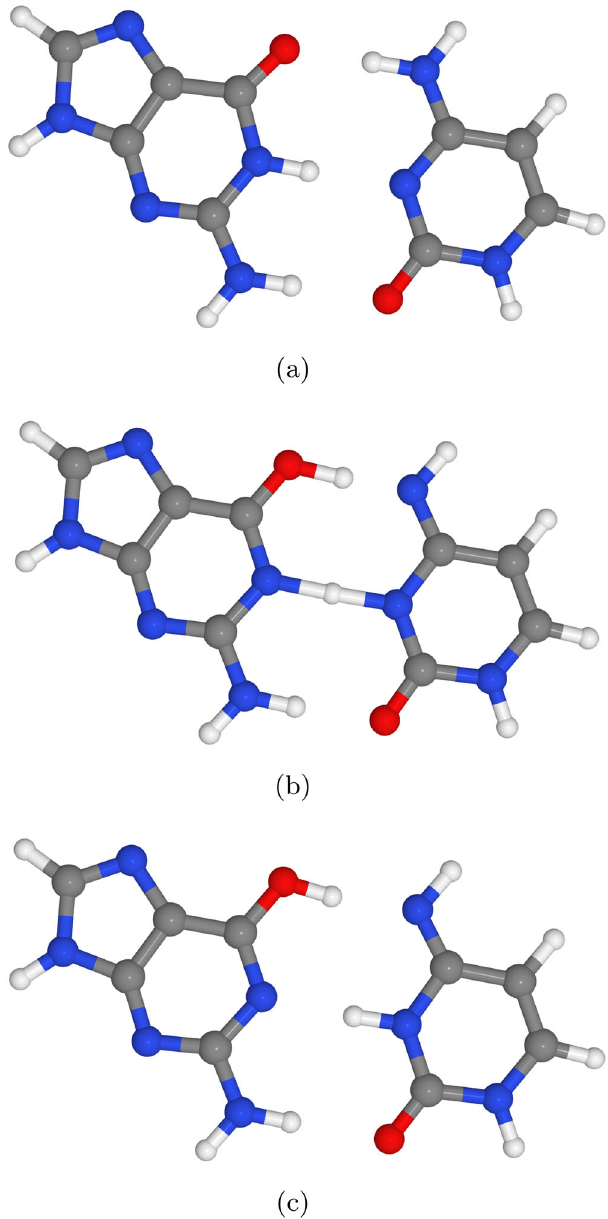
Fig. 1 Schematic depiction of the Guanine – Cytosine proton transfer reaction. a Rendering of the canonical standard form taken from the reaction path of Slocombe et al. 4 with permission from the Royal Society of Chemistry. b The energetic maximum along the reaction coordinate. c The potentially mutagenic tautomeric (enol-imino) non-standard form of the DNA base. Hydrogen atoms are shown in white, nitrogen in blue, carbon in grey, and oxygen in